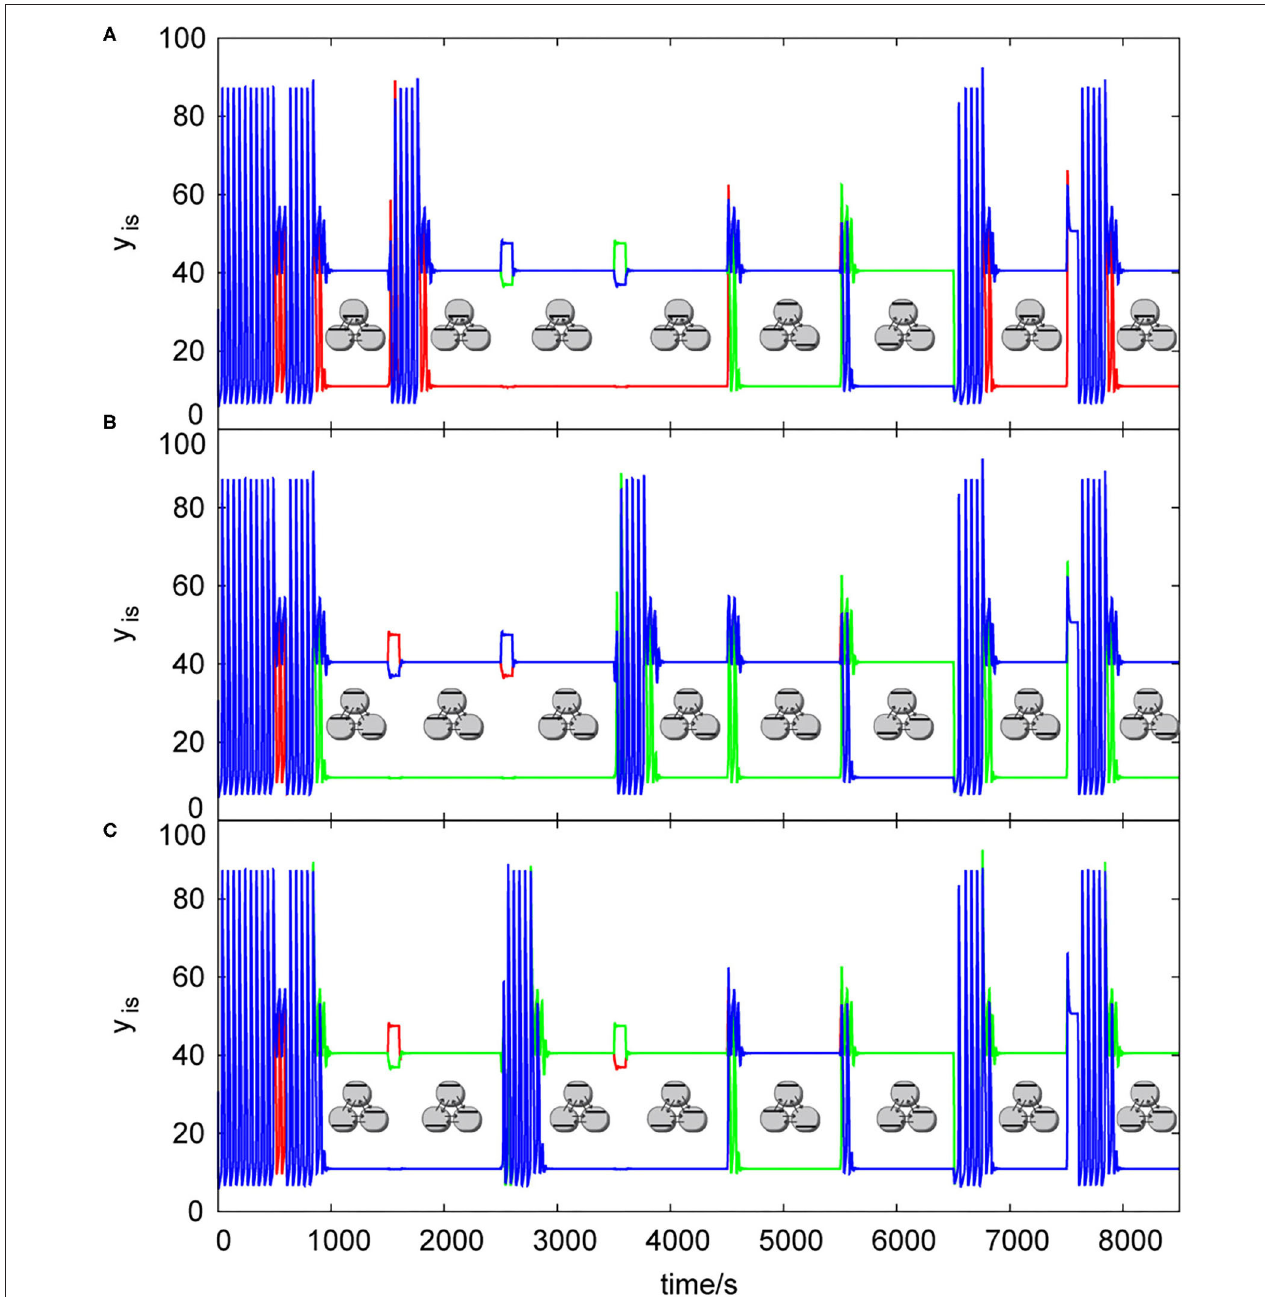
FIGURE 7 | List of dynamic simulations of three coupled cells in cyclic array using central knockout perturbations system, k ADP = 0.1 s − 1 , σ inh = 35 s − 1 , q = 1: (A) knockout perturbation {0 1 1}—resulting truth table Table 2B , (B) knockout perturbation {1 0 1}– resulting truth table Table 3A , (C) knockout perturbation {1 1 0}– resulting truth table Table 3B . Each pattern in this figure is shown by its symbolic